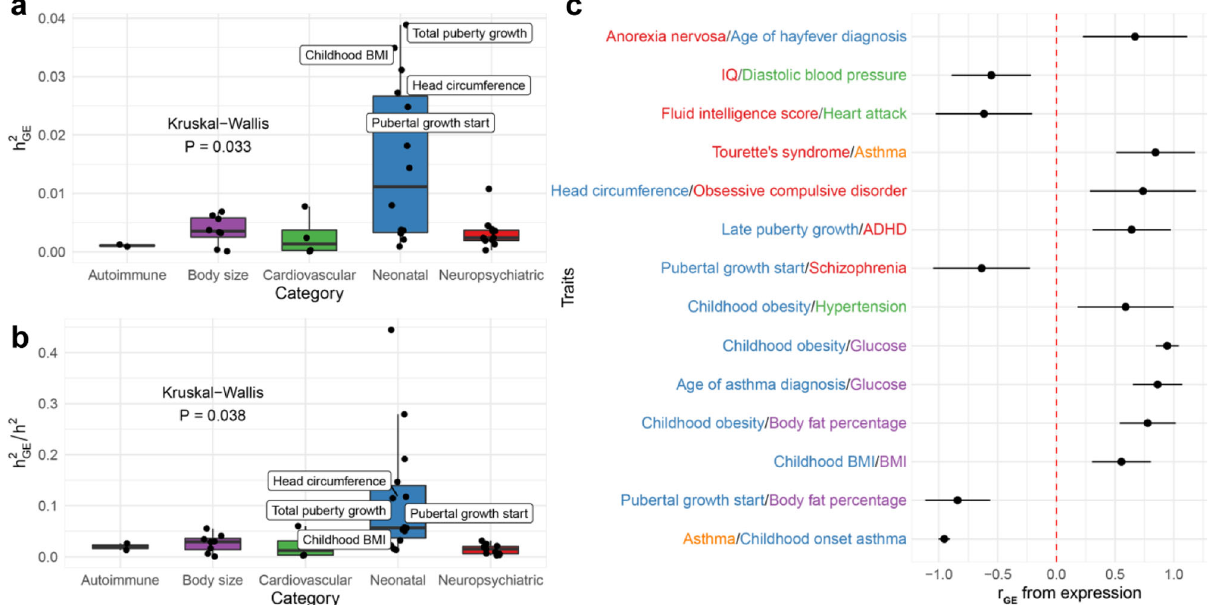
Fig. 4 Trait genetic heritability and correlations mediated by placental expression. a Box-plot of expression-mediated trait heritability ( h 2 GE ), estimated with LD-score regression, ( y -axis) by category ( x -axis), with labels if ^ h 2 GE is signi fi cantly greater than 0 using two-sided jack-knife test of signi fi cance. b Box-plot of expression-mediated trait heritability ( h 2 GE ) standardized by SNP heritability ( h 2 ) ( y -axis) by category ( x -axis), with labels if ^ h 2 GE is signi fi cantly greater than 0 using two - sided jack-knife test of signi fi cance. c Forest plot of signi fi cant placenta expression-mediated genetic correlations (shown as points) and 95% FDR-adjusted two-sided Wald-type con fi dence intervals between traits from different categories. Boxplots in a , b provide, in order of bottom to top, the lower extreme, lower quartile, median, upper quartile, and upper extreme. Sample sizes used to derive these statistics across a – c are provided in Supplementary Data